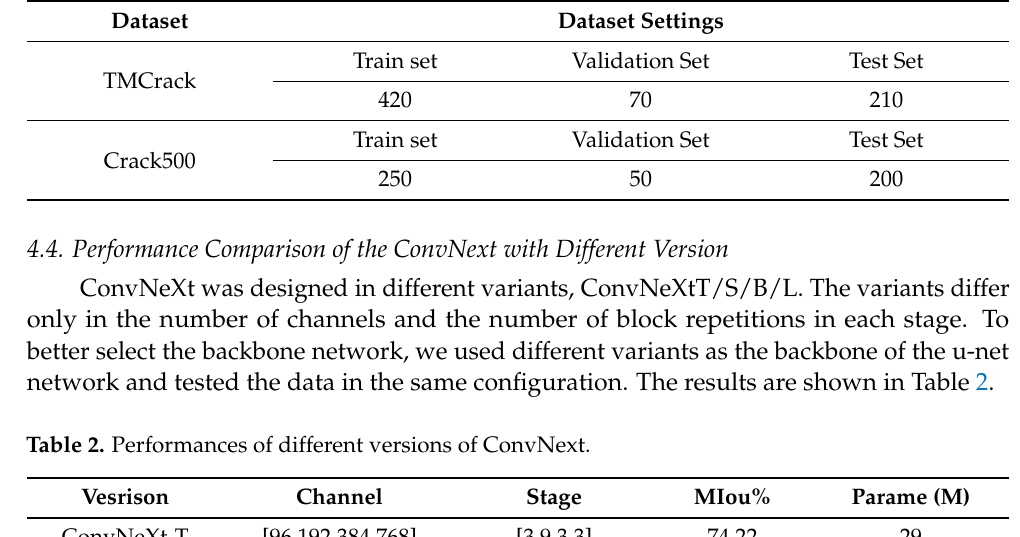
Table 1. Dataset settings.